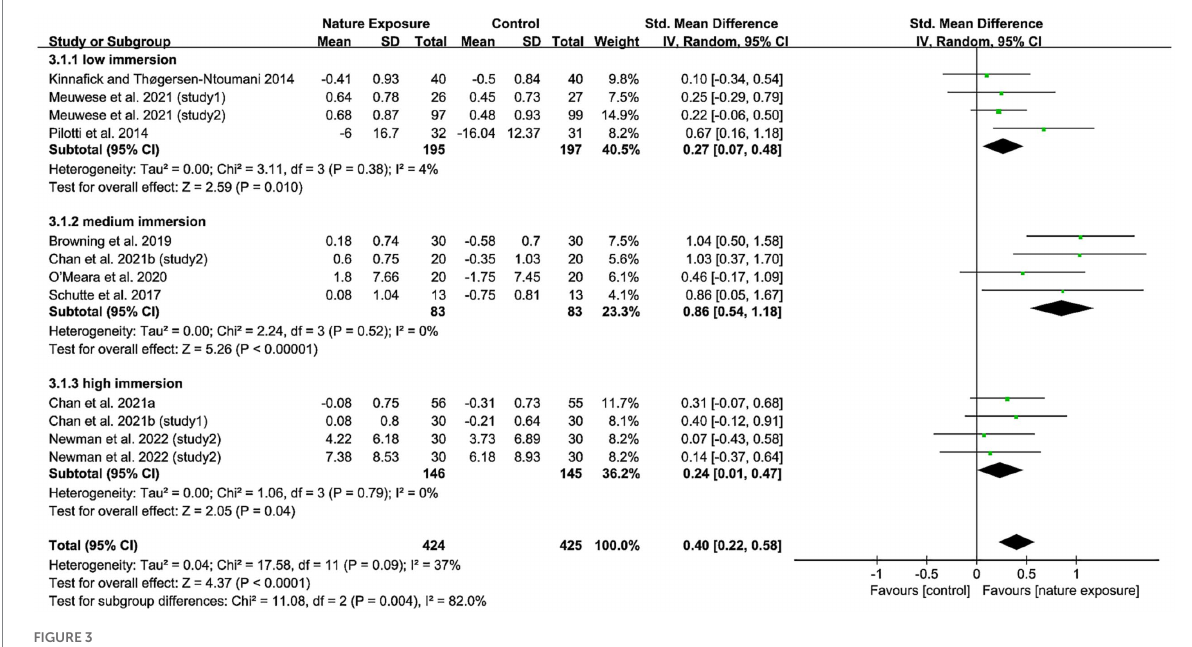
FIGURE 3 Subgroup analysis of the effects of simulated nature exposure on positive